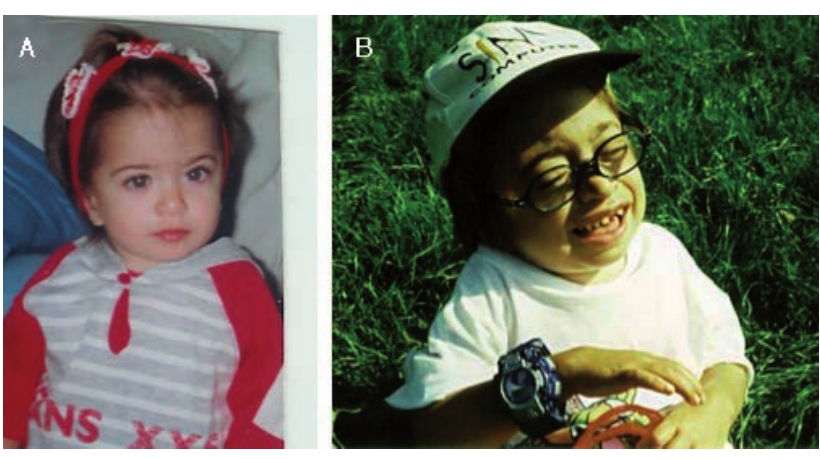
Figure 3. A and B) Same patient, affected by mucopolysaccharidosis type I H/S at 2 and 8 years